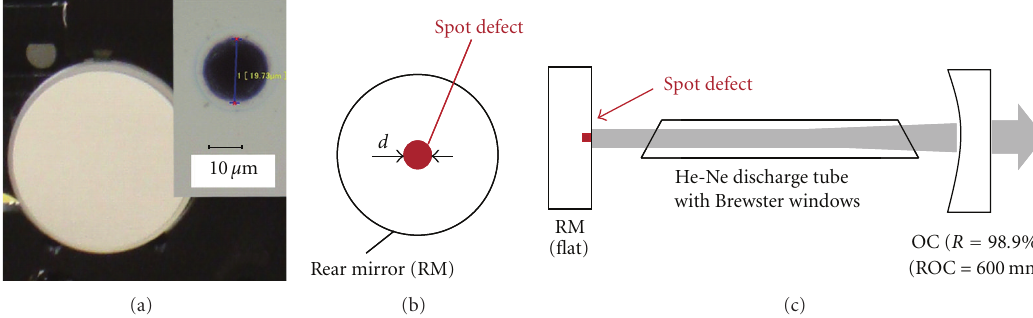
Figure 1: (a) A photograph of the fabricated spot defect mirror. The inset is a reflective optical microscope image of the mirror surface with a spot defect diameter of 20 μ m. Schematics of the spot defect mirror (b) and the He-Ne laser cavity (c).